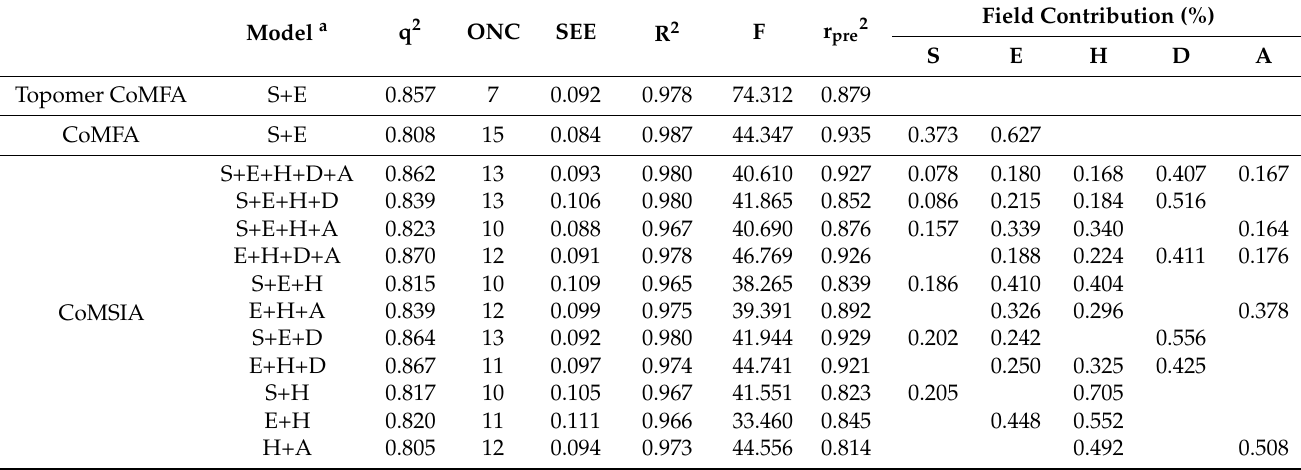
Table 2. Internal validation parameters of Topomer CoMFA, CoMFA, and CoMSIA models.